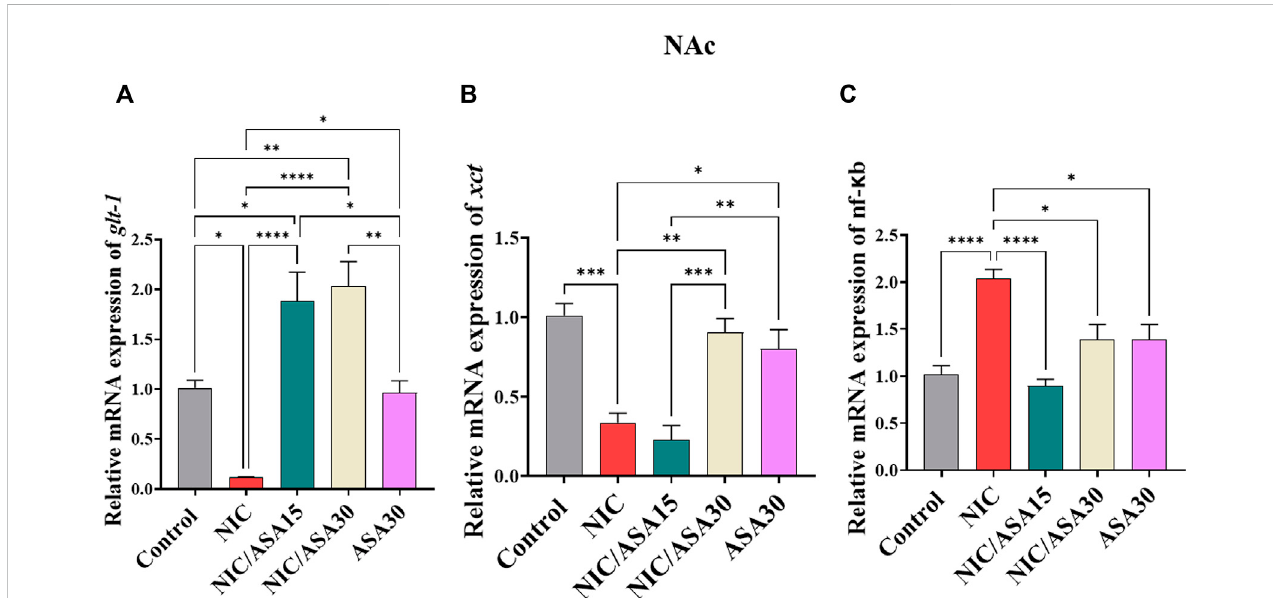
FIGURE 5 Relative glutamate transporters mRNA expression in NAc brain regions after treatments (data expressed as mean ± SEM). (A) glt-1; (B) xct; (C) nf κ B (* p < .05, ** p < .01, *** p < .001; n = 5 for each group).